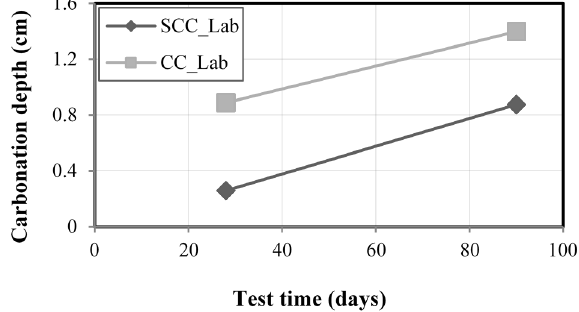
Figure 8. Accelerated carbonation test